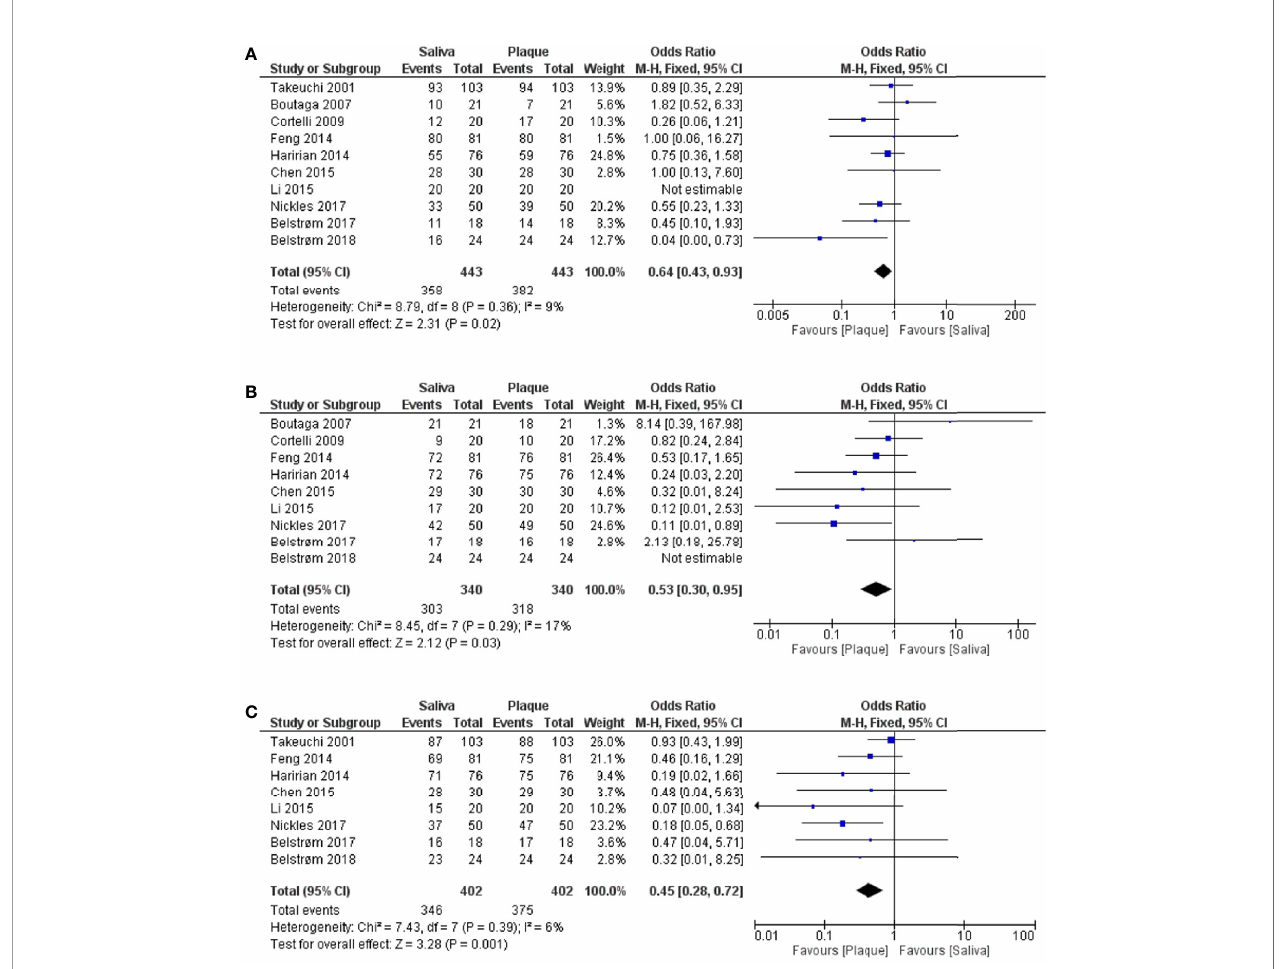
FIGURE 4 | Forest plots of meta-analyses comparing the detection frequency of: (A) P. gingivalis ; (B) T. forsythia ; (C) T. denticola between saliva and subgingival plaque samples from patients with periodontitis.